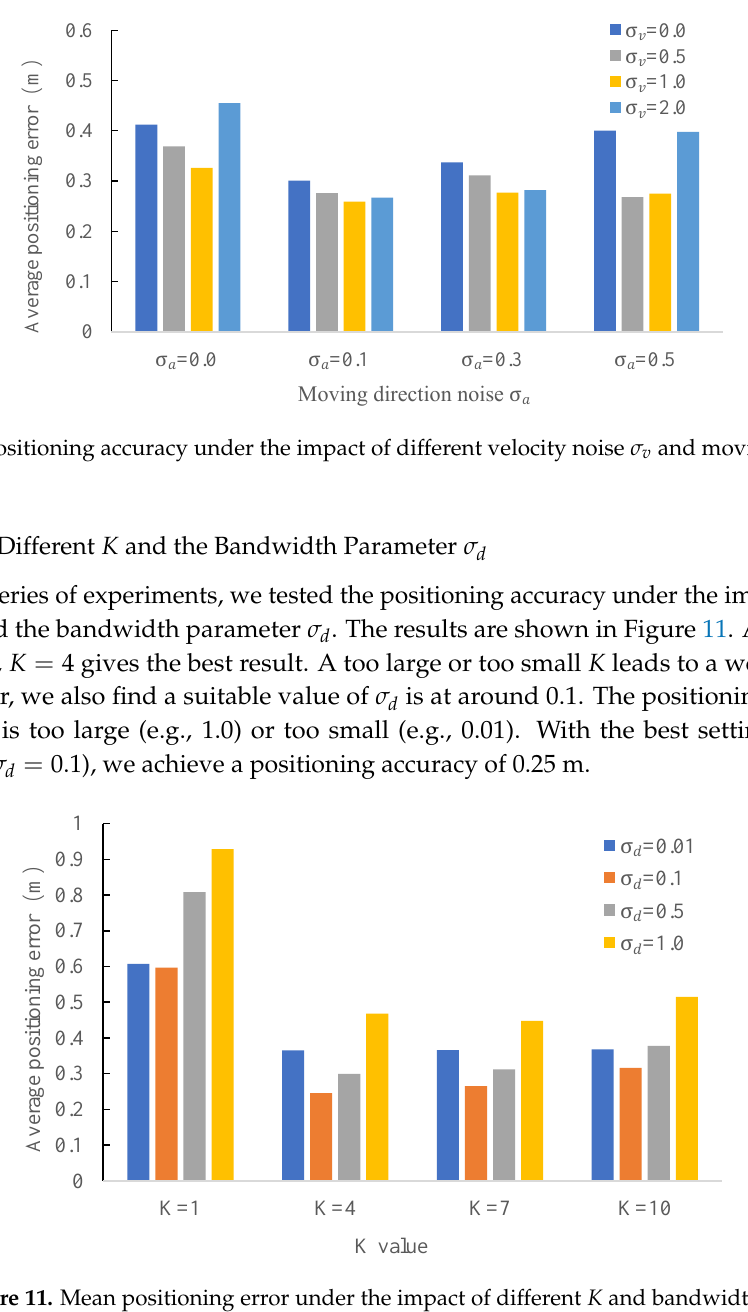
Figure 11. Mean positioning error under the impact of different K and bandwidth σ d